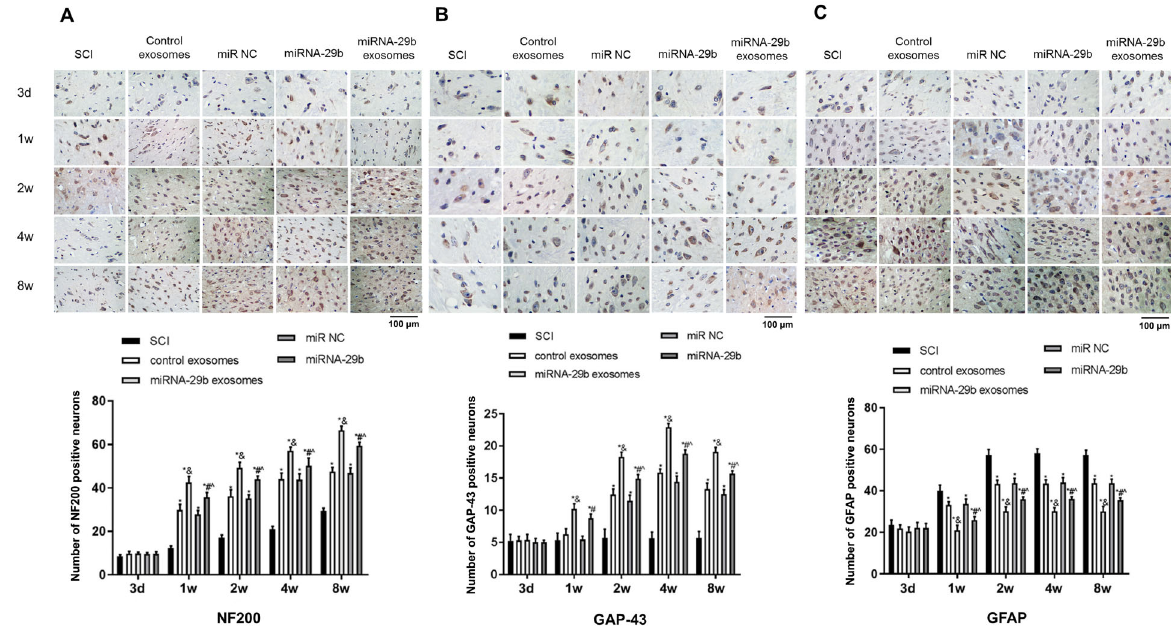
Figure 5. NF200 ( A ), GAP-43 ( B ), and GFAP ( C ) positive cells (brown) were observed in spinal cord tissues of spinal cord injury (SCI) rats by immunohistochemistry at 3 days, 1, 2, 4, and 8 weeks post-injection ( (cid:1) 500, bar=100 m m). Data are reported as means ± SD. *P o 0.05 vs SCI group; & P o 0.05 vs control exosomes; # P o 0.05 vs miR NC; ̂ P o 0.05 vs miRNA-29b exosomes